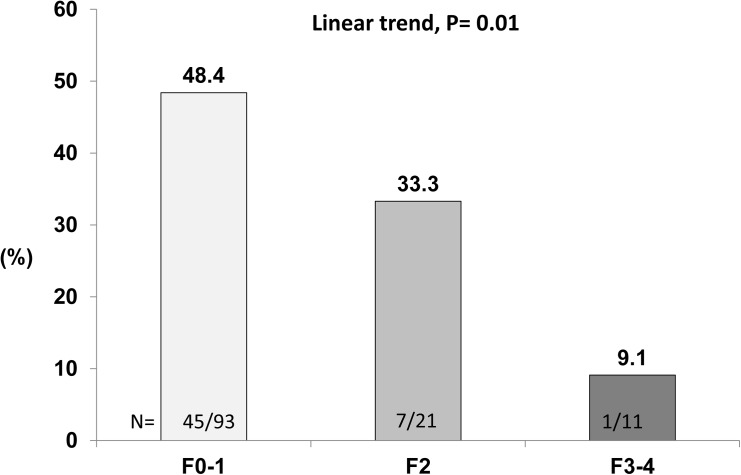
The presence of hyperuricemia according to fibrosis stages among NASH patients.